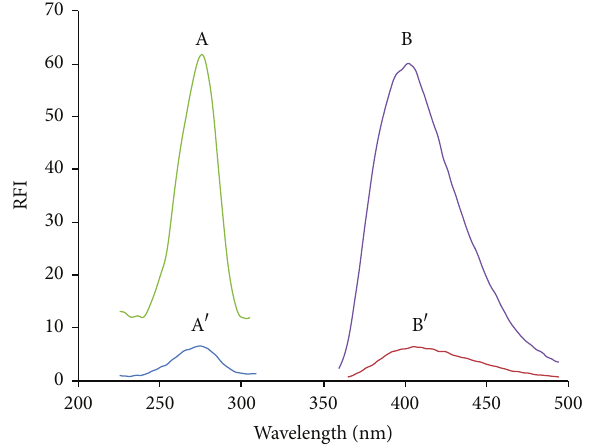
Figure2:Fluorescencespectraof(A,B)GFX(500 ng/mL)inacetate buffer, pH 5.5/SDS system; (A 󸀠 , B 󸀠 ) GFX (500ng/mL) in acetate buffer, pH 3.5, where (A, A 󸀠 ) are the excitation spectra and (B, B 󸀠 ) are the emission spectra.